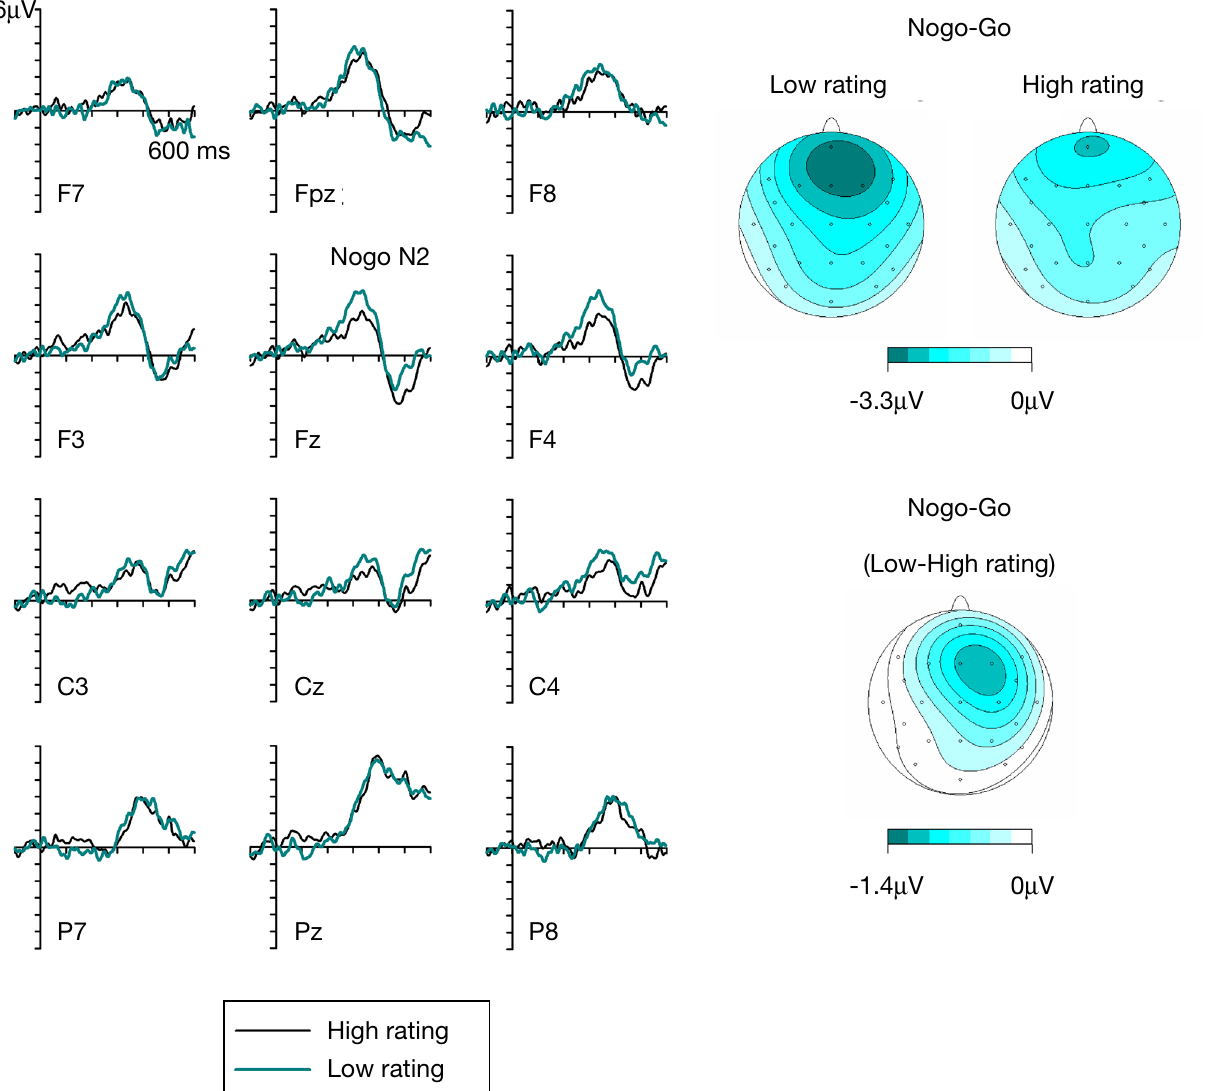
Figure 4 | Left panels show difference waveforms obtained by subtracting Go trials from Nogo trials, separately for faces that subsequently received a high (black line) or low (dark cyan line) trustworthiness rating. Right panels show topographical maps of Nogo–Go difference waveforms obtained in the Nogo N2 time window (250–350 ms post-stimulus) for faces that were later judged as low or high in their trustworthiness. Bottom right panel: Scalp topography of the difference of the Nogo N2 in the same time window as a function of subsequent trustworthiness ratings, computed by subtracting Nogo–Go difference waveforms for high-rated faces from Nogo–Go difference waveforms for low-rated